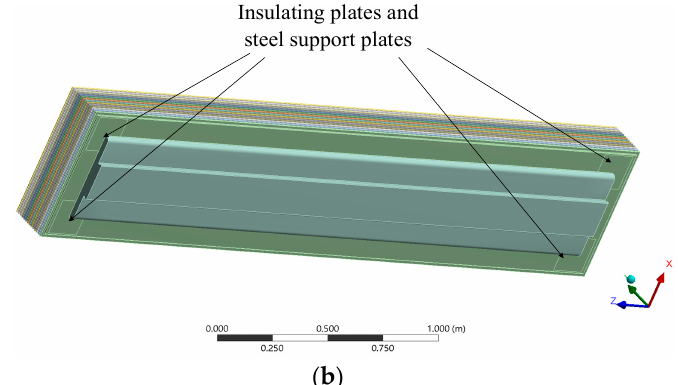
Figure 3. Rotor magnetic pole structure ( a ) pole shoe; and ( b ) pigeon tail.